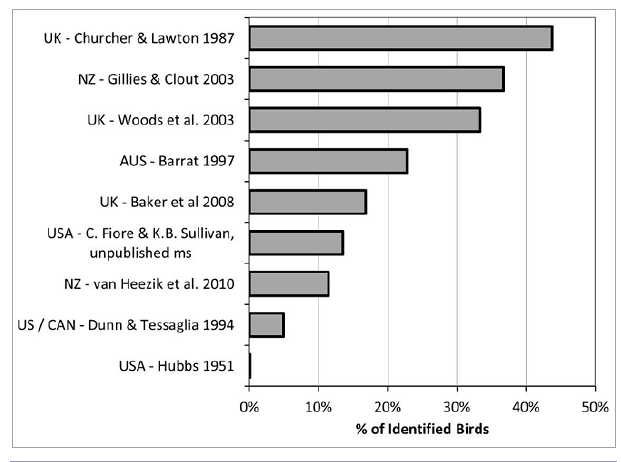
Fig. 6 . House Sparrows as a percent of identified birds in house cat diet from nine studies. All studies included at least 60 identified birds and at least 40